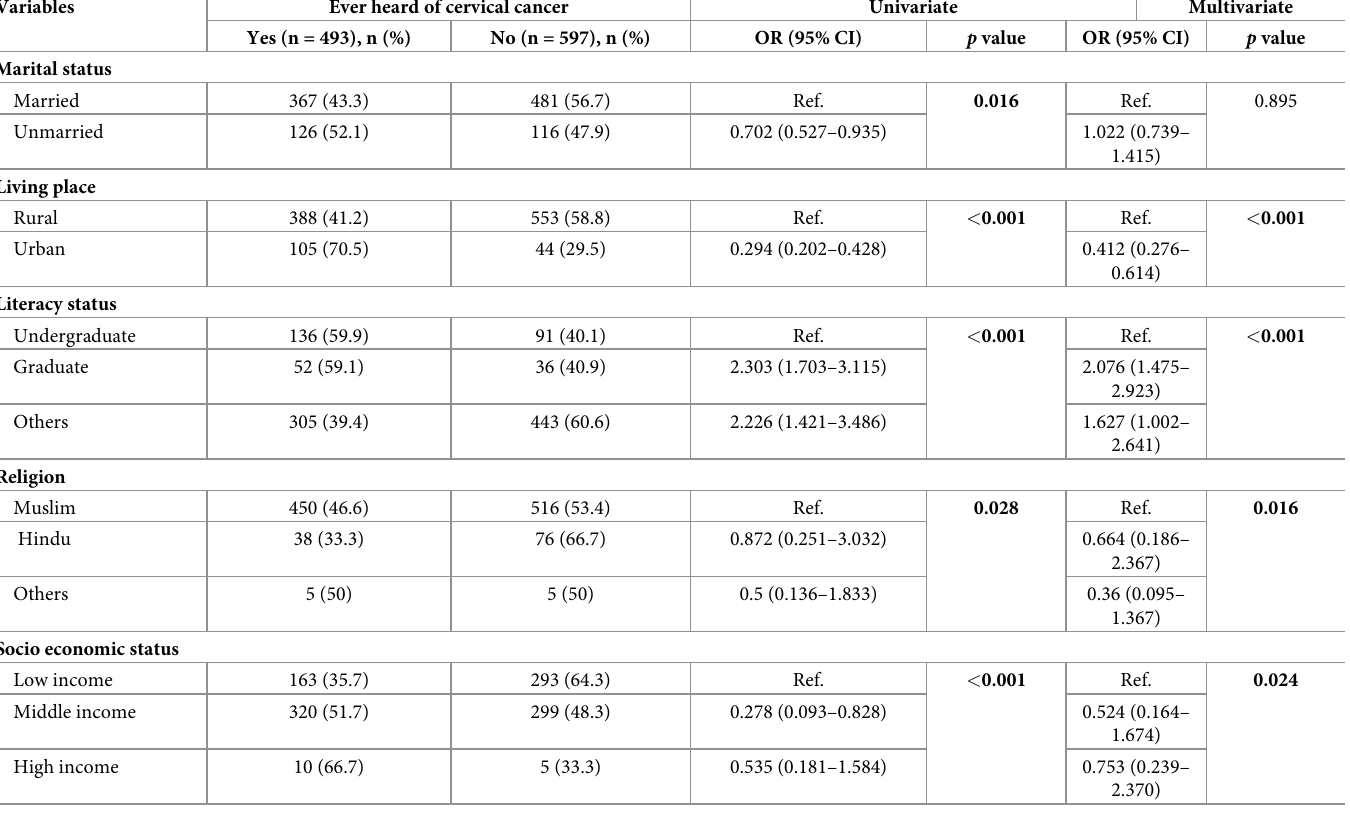
Table 2. Univariate and multivariable analyses of factors associated with ever heard of cervical cancer (Q8).